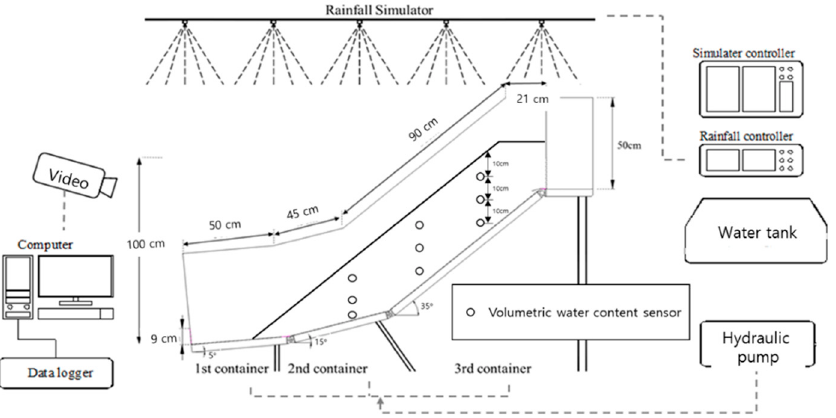
Table 2. Measurement depths at different slope angles.